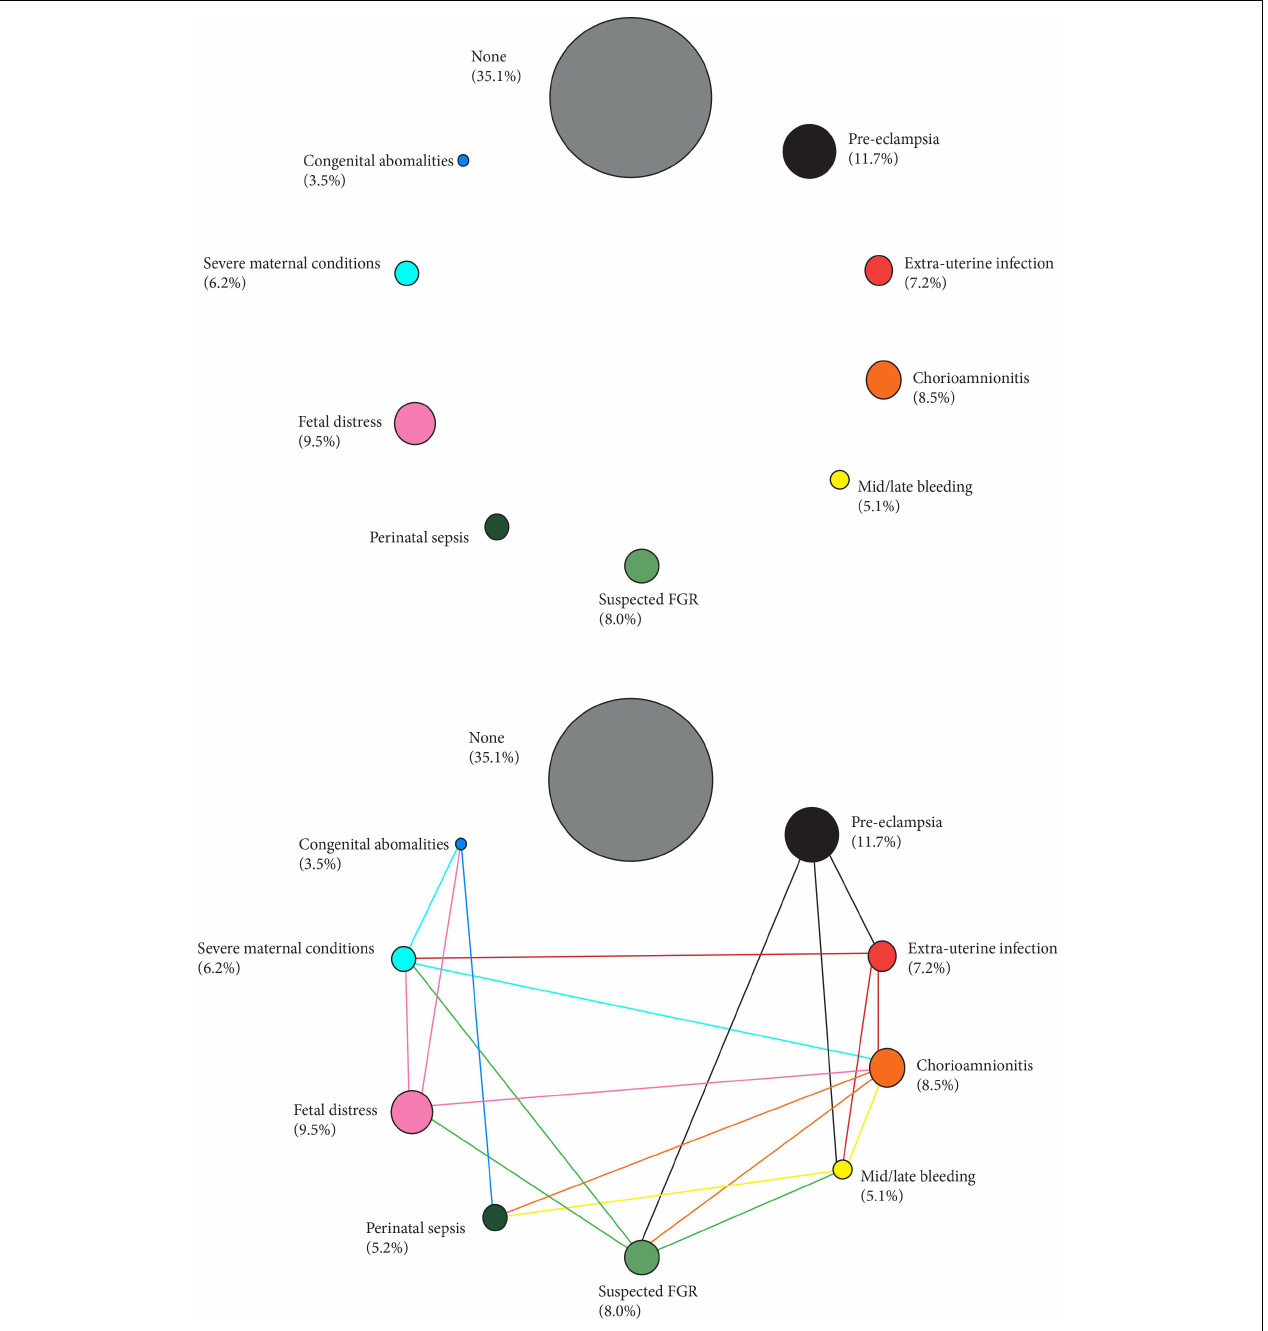
FIGURE 1 | Preterm phenotypes and the complex interaction amongst their aetiological factors. Size of the circles represent the prevalence of the phenotype (%) in a recent multi-country population (Villar et al., 2021b). Links across phenotypes adapted from Barros et al. (2015).